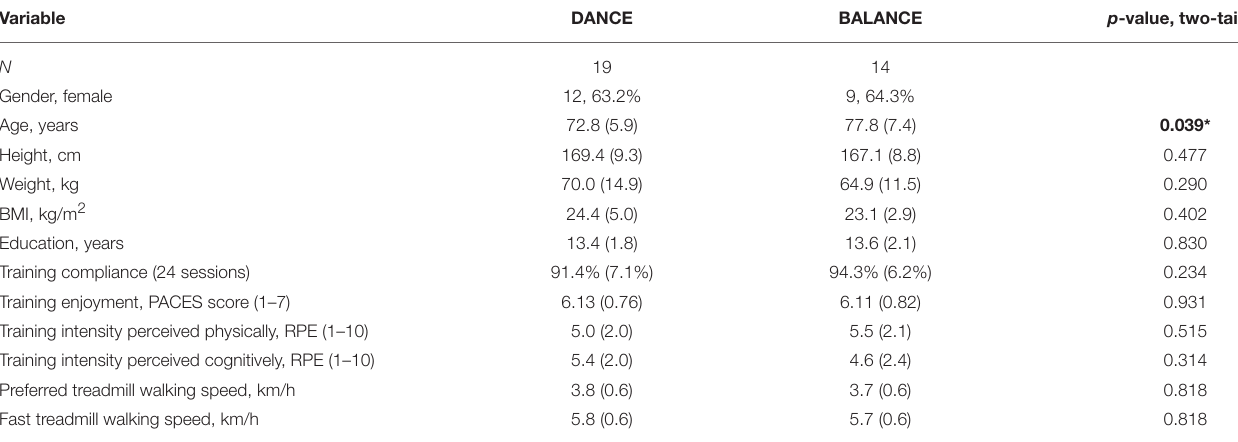
TABLE 1 | Demographics and training characteristics.